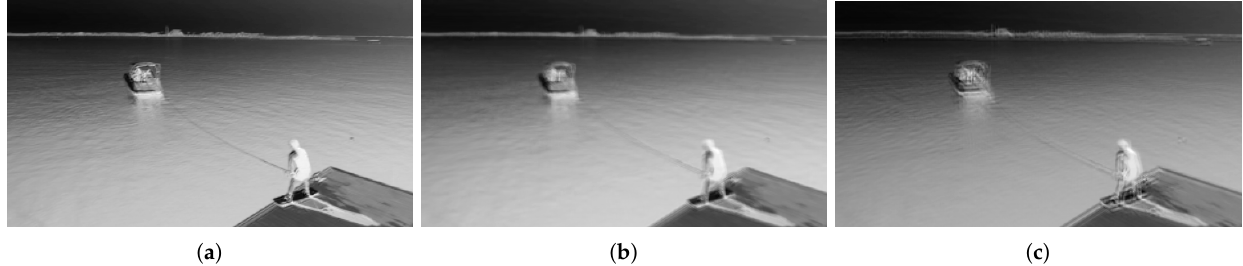
Figure 2. Filter examples derived from different streams of the proposed pipeline. Kernels of size 3 × 3, 5 × 5, and 7 × 7, applied to the same image, are shown in ( a – c ), respectively.